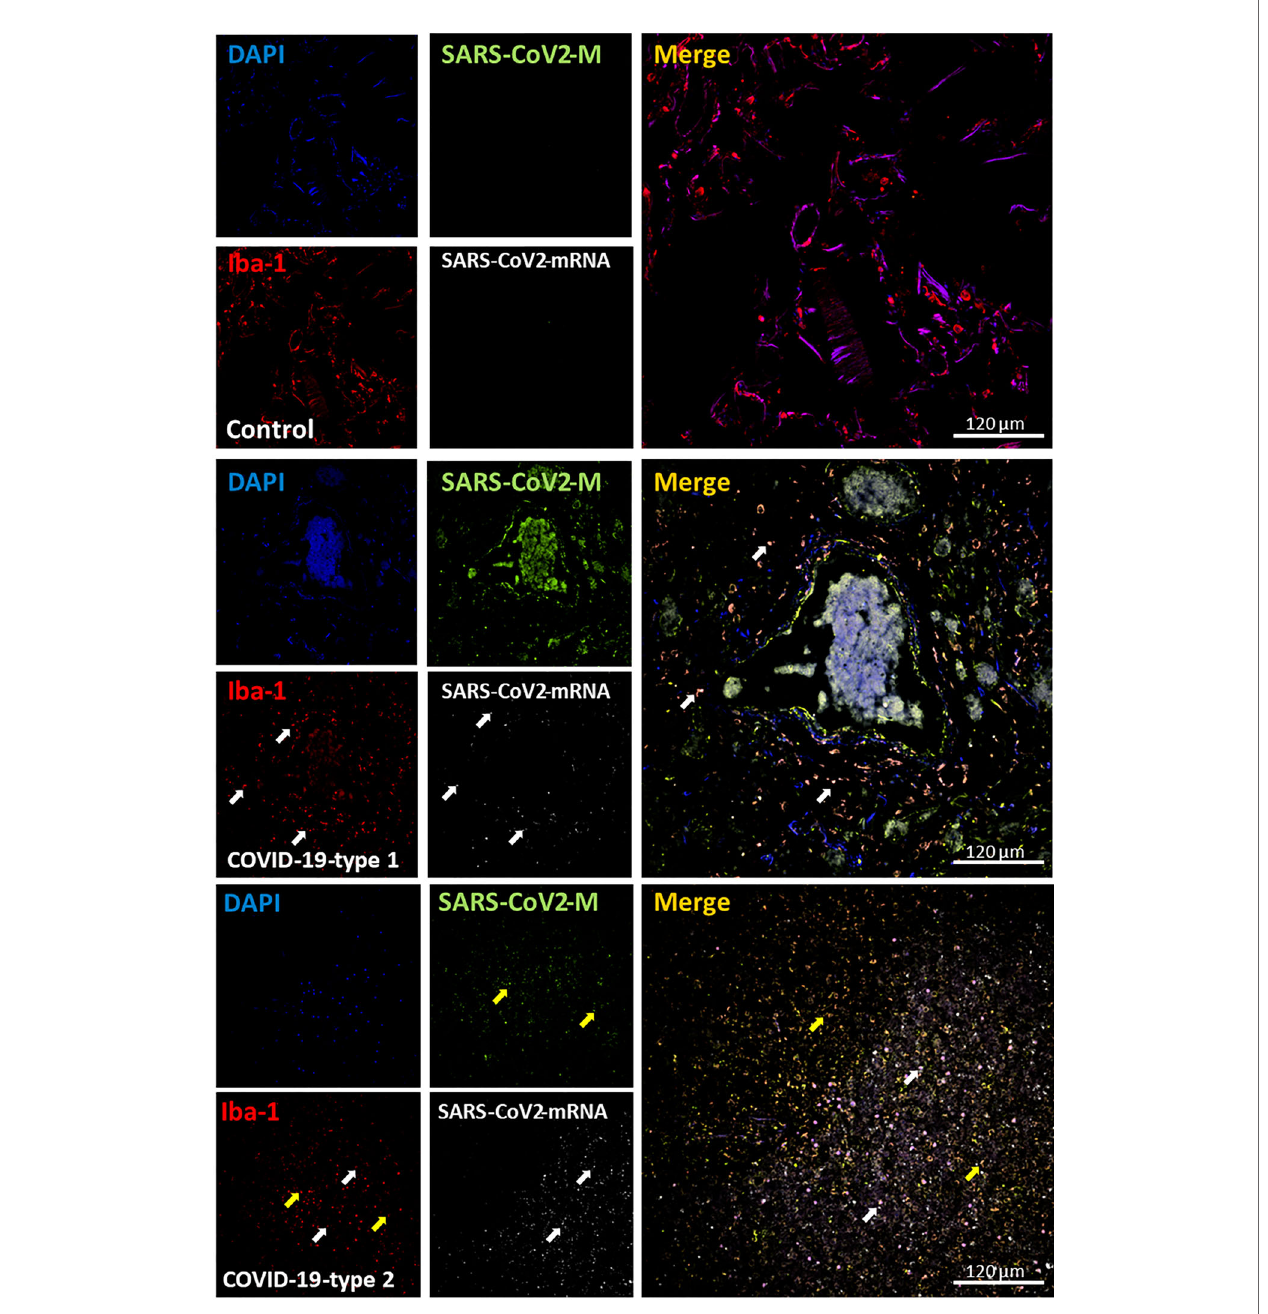
FIGURE 5 | COVID-19 disease induces a signi fi cant in fi ltration into the lung, and a small percentage of macrophages contained viral proteins and mRNA. Staining for nuclei (DAPI, blue staining), SARS-CoV-2 protein M (SARS-CoV-2-M, green staining), Iba-1 (macrophages, red staining), and SARS-CoV-2-mRNA (White staining) was performed. 3D reconstructions of lung samples collected from uninfected (control) and COVID-19 (Type 1 or 2, enhanced coagulation and immune in fi ltration). In control conditions, macrophages (Iba-1 positive cells) underline the alveolar wall, and no unspeci fi c viral protein or mRNA staining was found as expected (Control). In contrast, the enhanced coagulation phenotype (COVID-19, type I, damage) showed a signi fi cant proliferation or migration of macrophages cells (COVID-19-type 1). Also, a small population of Iba-1 positive cells was positive for viral mRNA (see white arrows) and SARS-CoV-2 protein M (yellow arrows). Most viral protein M was concentrated inside blood vessels. In immune in fi ltrating conditions, also we observed a signi fi cant increase in monocyte/macrophage in fi ltration with a small population of macrophages positive for viral mRNA (white arrow) and protein M without viral mRNA (yellow